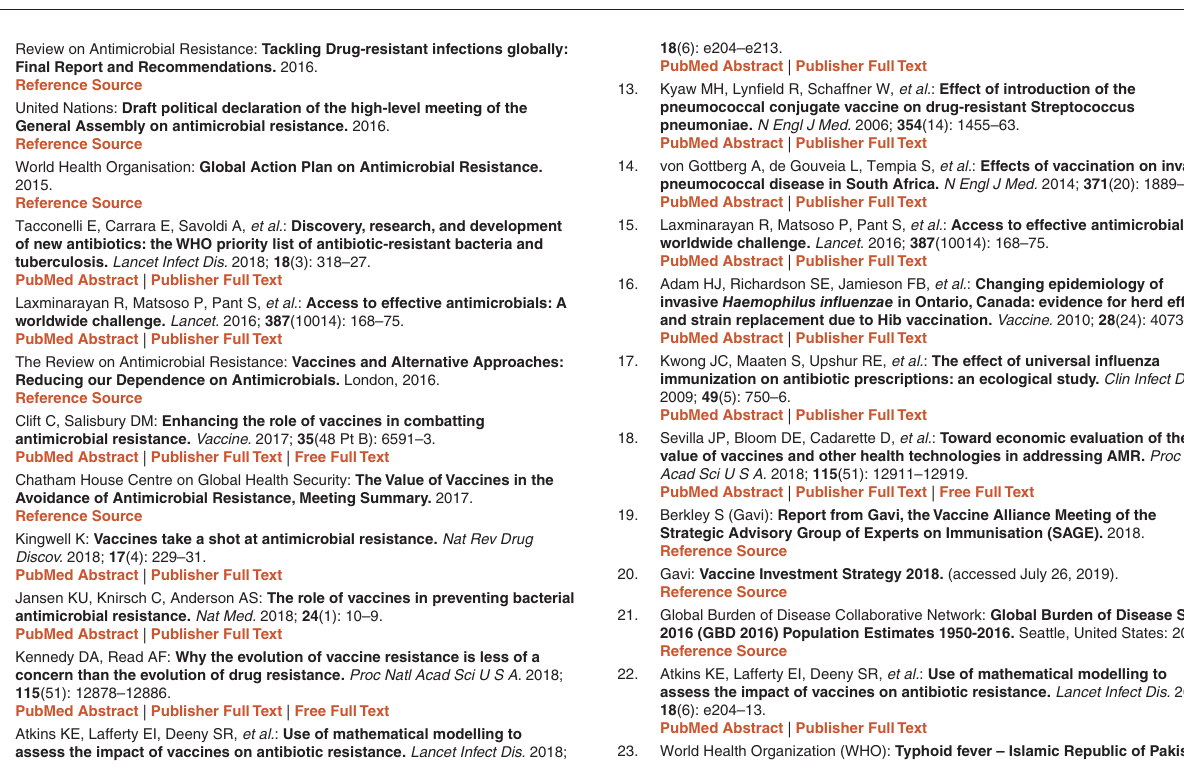
Figshare: AMR GAVI VIS underlying data. https://doi.org/10.6084/ m9.figshare.9724229 33